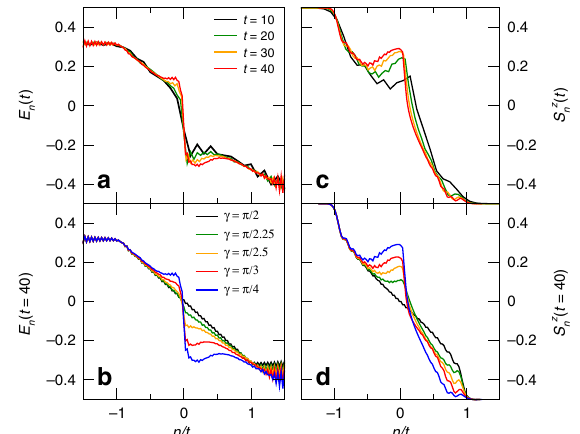
Fig. 2 Energy and magnetization pro fi les during the relaxation process. of time; b energy pro fi le at the longest accessible time, t ¼ 40, and several values of γ . Spin-transport scenario: c magnetization pro fi le for γ ¼ π = 4